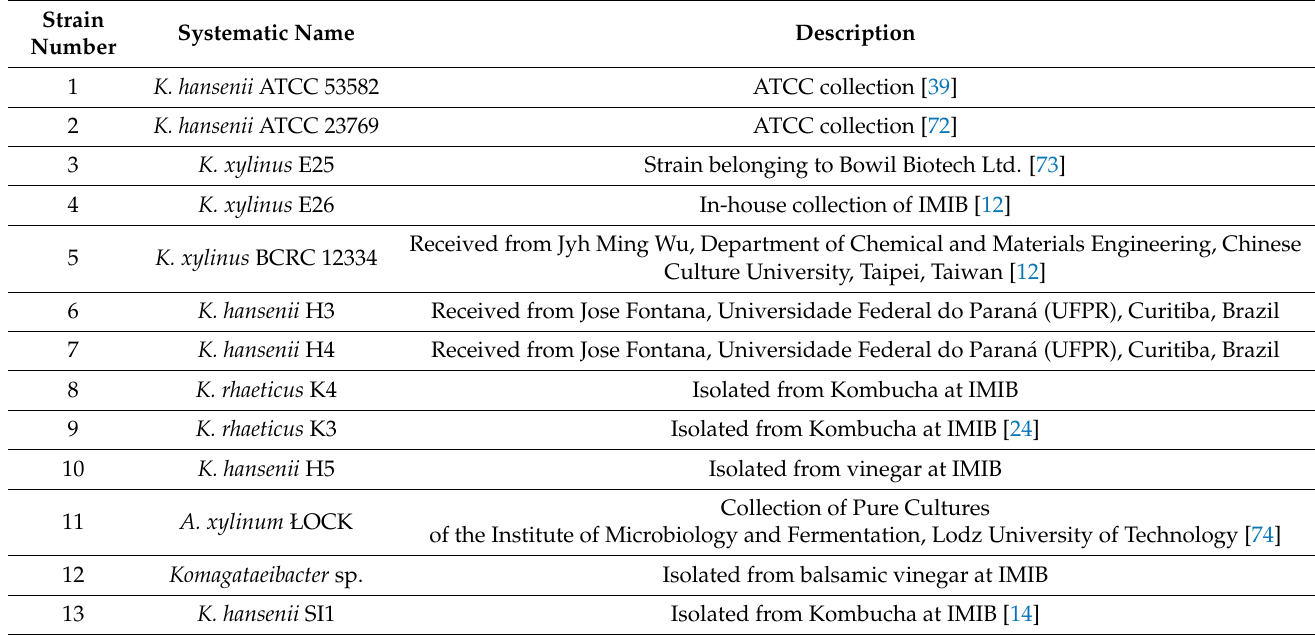
Table 1. Bacterial strains of the Komagataeibacter genus used in the